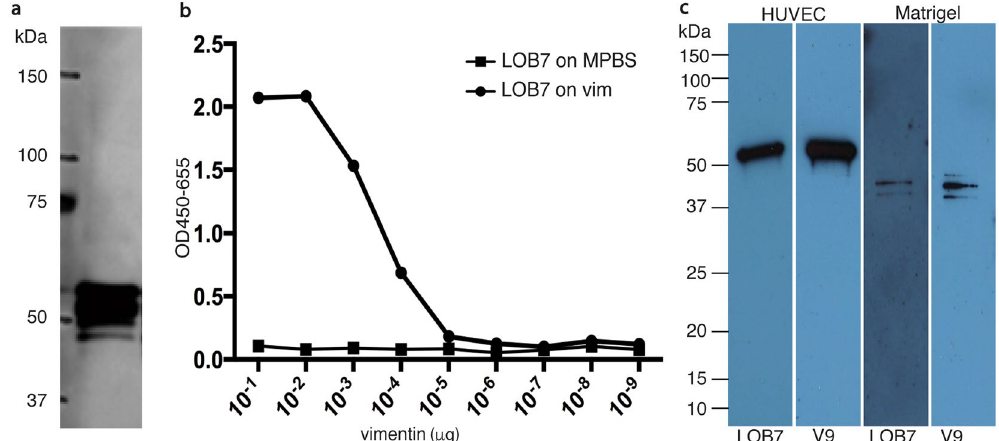
Figure 1. Characterisation of LOB7. Top panel: ( a ) The commercial mouse anti-vimentin V9 was used to identify vimentin in the sample of immuno-precipitated proteins. ( b ) LOB7 presented on phage was tested against vimentin in ELISA. A dilution series of vimentin was coated in the wells of an ELISA plate and detected using the same amount of LOB7 presented on phage. ( c ) Western blot using the commercial mouse anti-vimentin V9 and LOB7 respectively on cytoplasmatic extracts from HUVEC cells and extracts from the extracellular matrix